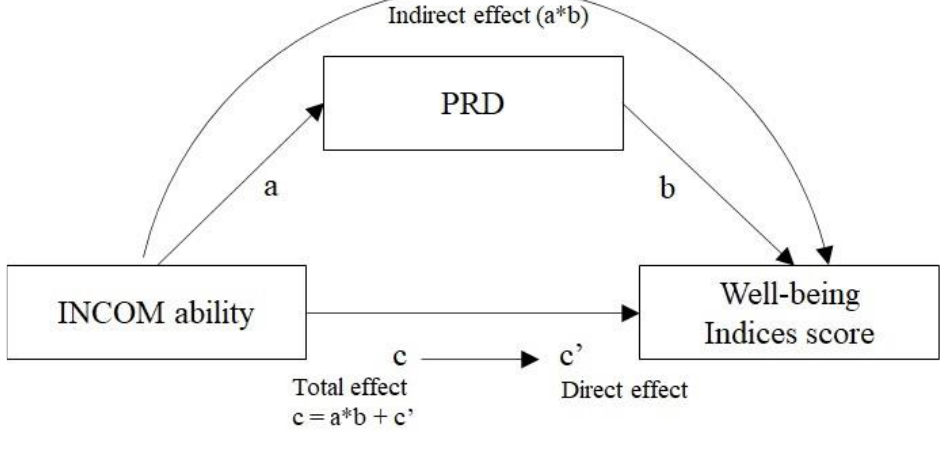
Figure 1. Mediation analysis model.